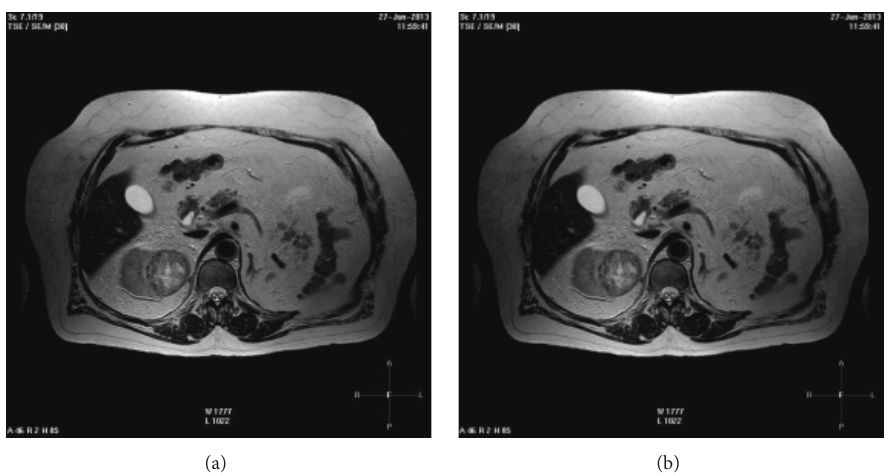
Figure 8: Common MRI imaging of a patient’s kidney: (a) original diagnostic image; (b) watermarked